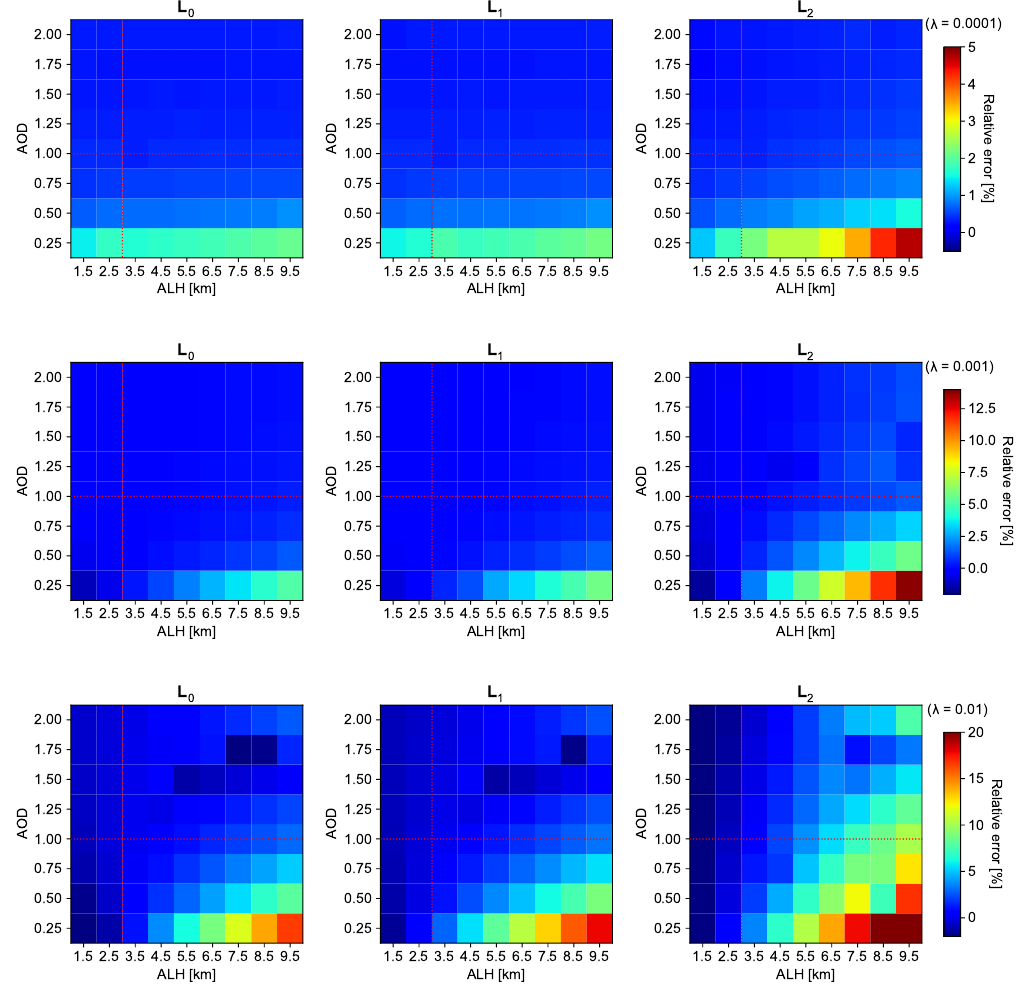
Figure 4. Error of AOD retrieval for three regularization matrices. The x - and y -axes represent the true values of ALH and AOD, respectively. The value of λ is displayed above each color bar. The dotted red lines refer to the a priori values of ALH and